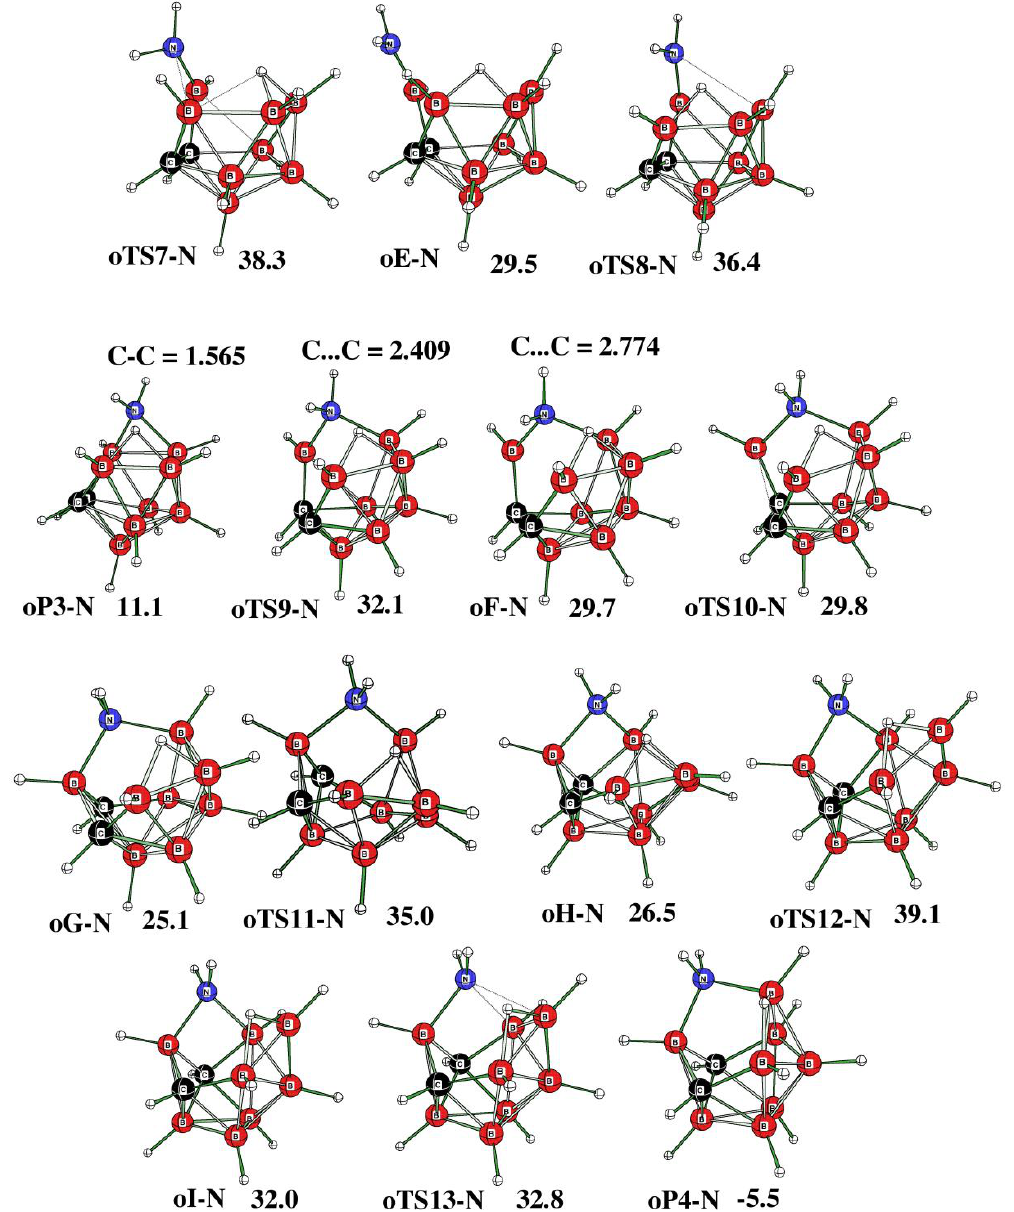
Figure 3. Individual stationary points on the PES of the reaction of closo -1,2-C 2 B8H 10 with NH 3 .